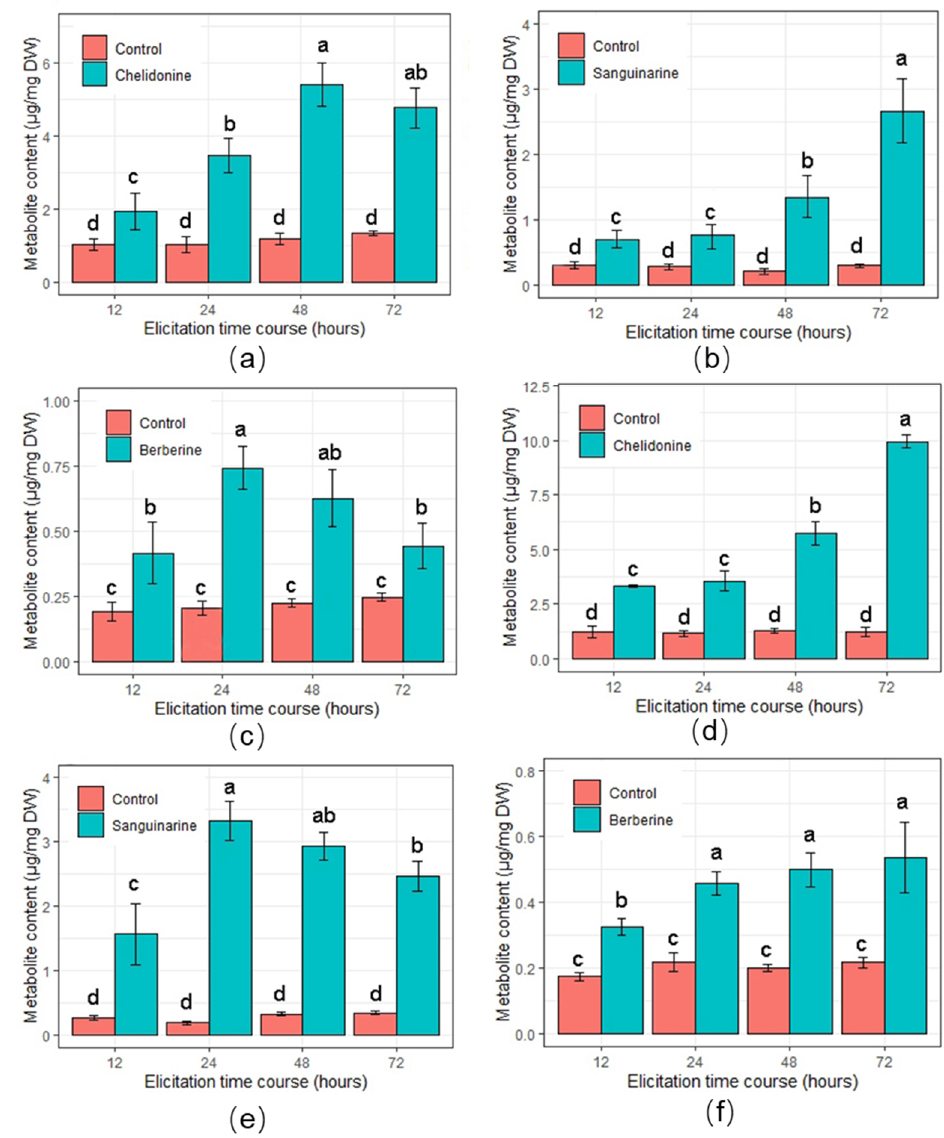
Figure 4. Effects of abiotic elicitors on the accumulation BPAs in cultured Greater Celandine cells. ( a ) chelidonine, ( b ) sanguinar- ine, and ( c ) berberine after elicitation by SA at 12, 24, 48, and 72 h. ( d ) Chelidonine, ( e ) sanguinarine, and ( f ) berberine after elicitation by MJ at 12, 24, 48, and 72 h. Non-elicited cells were used as control. Each column represents the mean value with the SD bar from three biological and three technical replicates. The significant difference is calculated by LSD (least significant difference) statistical analysis at the level of p ≤